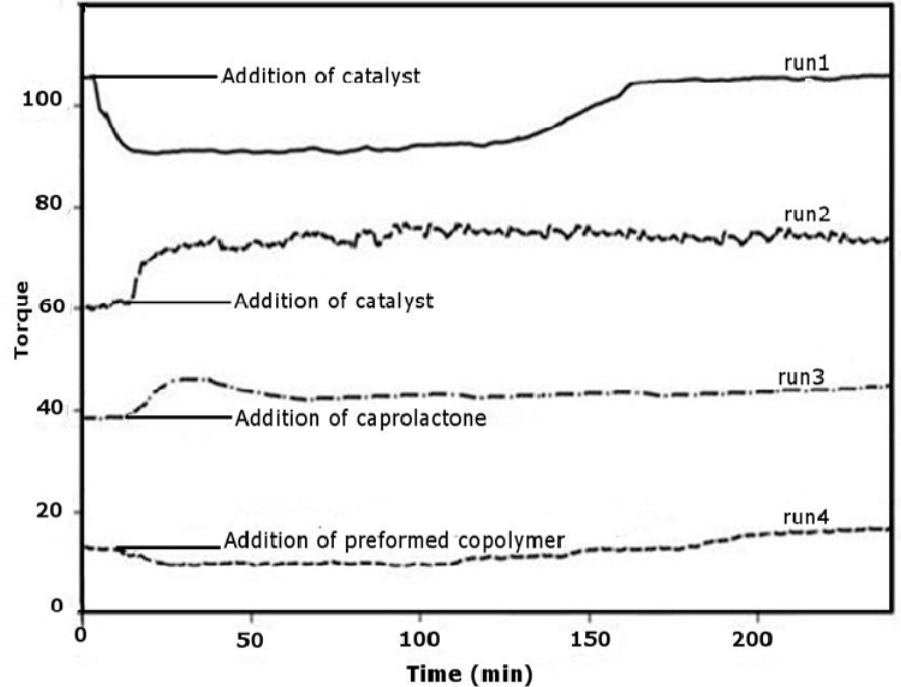
Figure 1. Torque evolution during the reaction between poly(ethylene- co -vinyl alcohol) (EVOH), PCL and ε -caprolactone. At 176 °C, catalyst = SnOct